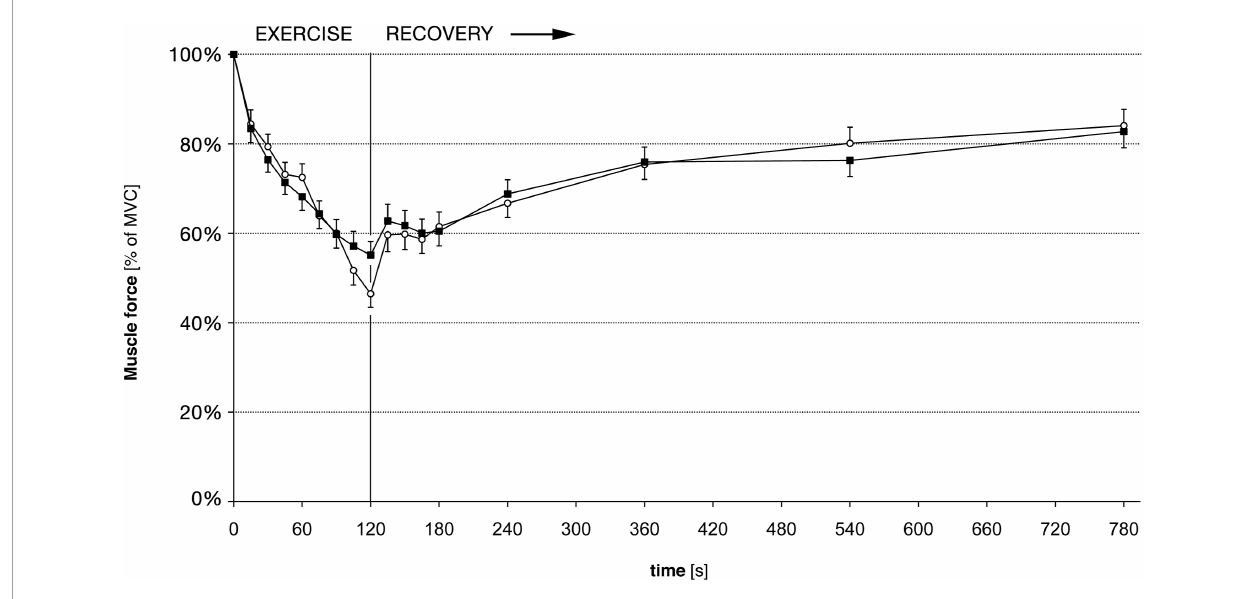
FIGURE 2 Muscle force for 5th finger abduction, before and after training. Force is given in percent of the maximal voluntary force (MVC); hence a training induced gain of force is not accounted for. White circles: force before training. Black squares: Force after training. Error bars denote standard error of the mean. There are no statistically significant differences of force pre-to post-training.